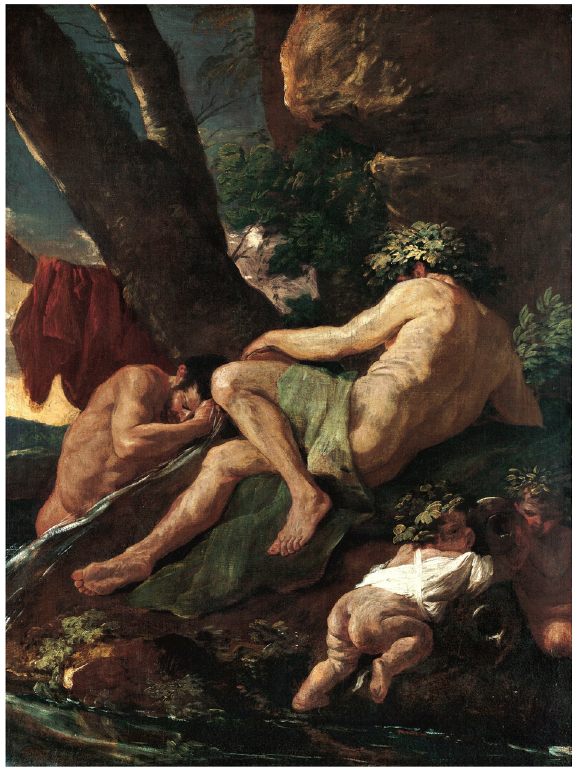
Figure 20: Poussin, Midas se lavant à la source de la rivière Pactole , 1627/1630. Metropolitan Museum of Art, NYC. Public